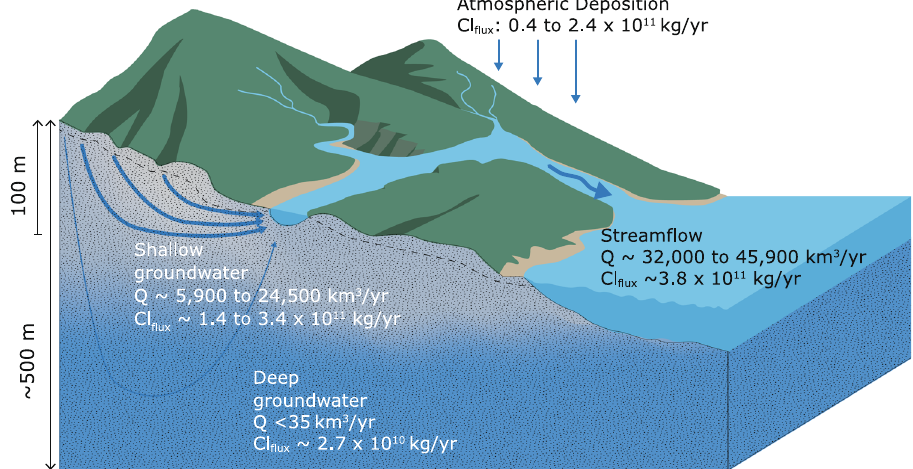
Fig. 4 Deep groundwater contributes less than 0.6% of global stream fl ow but is responsible for ~7% of the Cl fl ux. The transition between shallow groundwater (gray blue) and deep groundwater (dark blue) will be controlled by some combination of permeability and negative buoyancy and will be gradual rather than sharp in most settings. Deeper circulation of meteoric water will likely be common in orogenic belts, especially those with large-scale